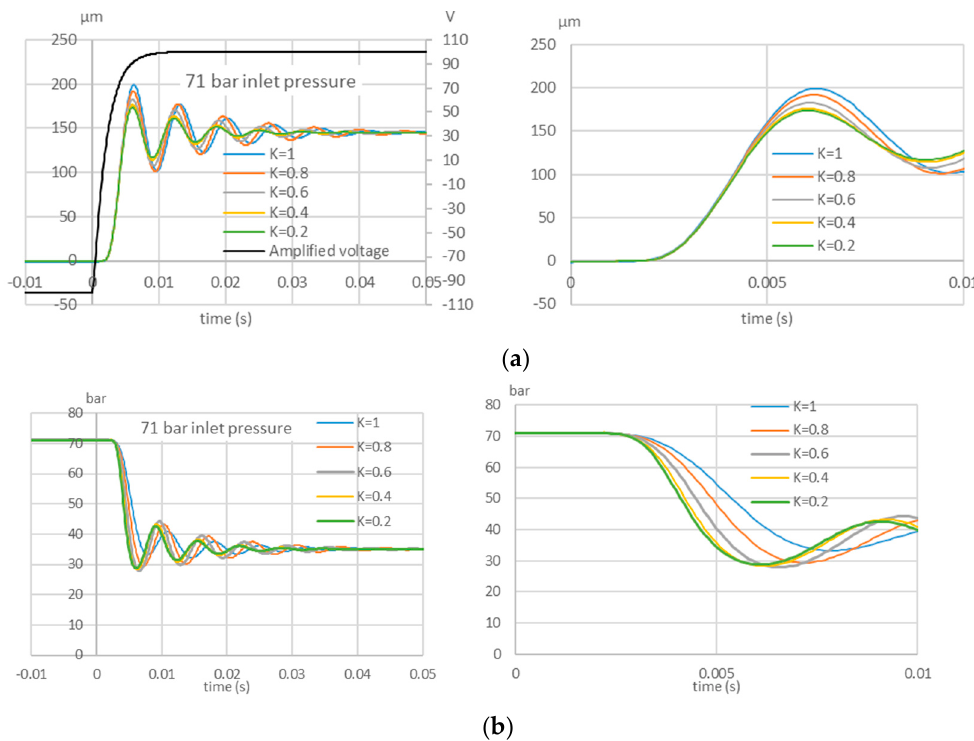
Figure 11. Ring bender displacement with enlargement ( a ) and pressure at point 7 with enlargement ( b ), simulated for an amplified voltage from − 100 V to +100 V and for different volumes of the chamber comprised between the restriction (6) and the nozzle (10), having diameter D = K D 0 and length L = K L 0 , with K = 1, 0.8, 0.6, 0.4, 0.2 (supply pressure = 71 bar).